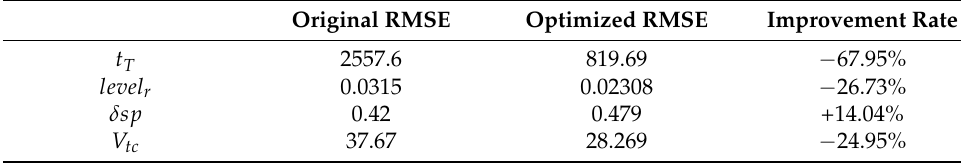
Table 5. The RMSE of the prediction errors.